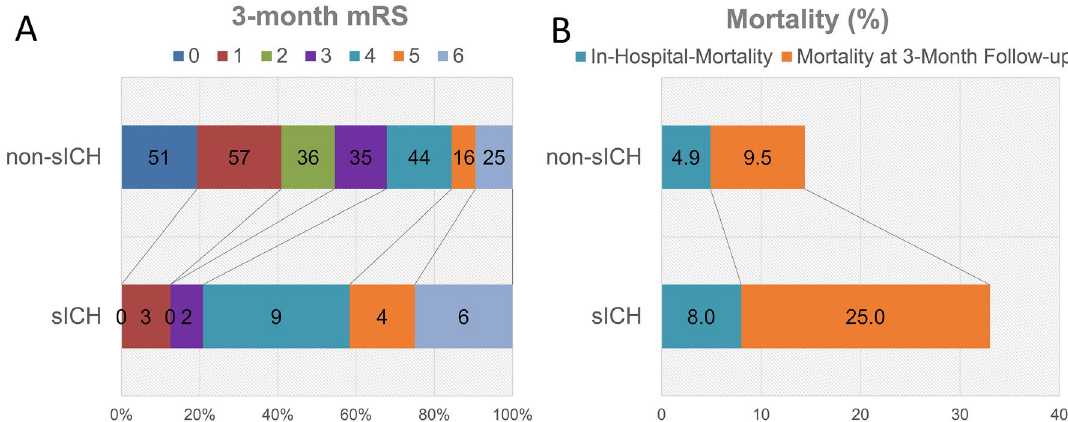
Figure 2. The 3-month functional outcomes of the patients with and without sICH after tPA treatment. Chart showing the differential 3-month mRS of patients with or without sICH of tPA administration ( A ). The numbers in each color-coded bar indicate the number of patients from the sICH or non-sICH group. ( B ) Graphical representation of the mortality outcomes of patients with and without sICH during hospitalization and during the 3-month post-tPA follow-up period. Numbers in the color-coded bar represent the percentage of patients in each group. sICH, symptomatic intracranial hemorrhage; mRS, modified Rankin Scale; tPA, tissue plasminogen activator.